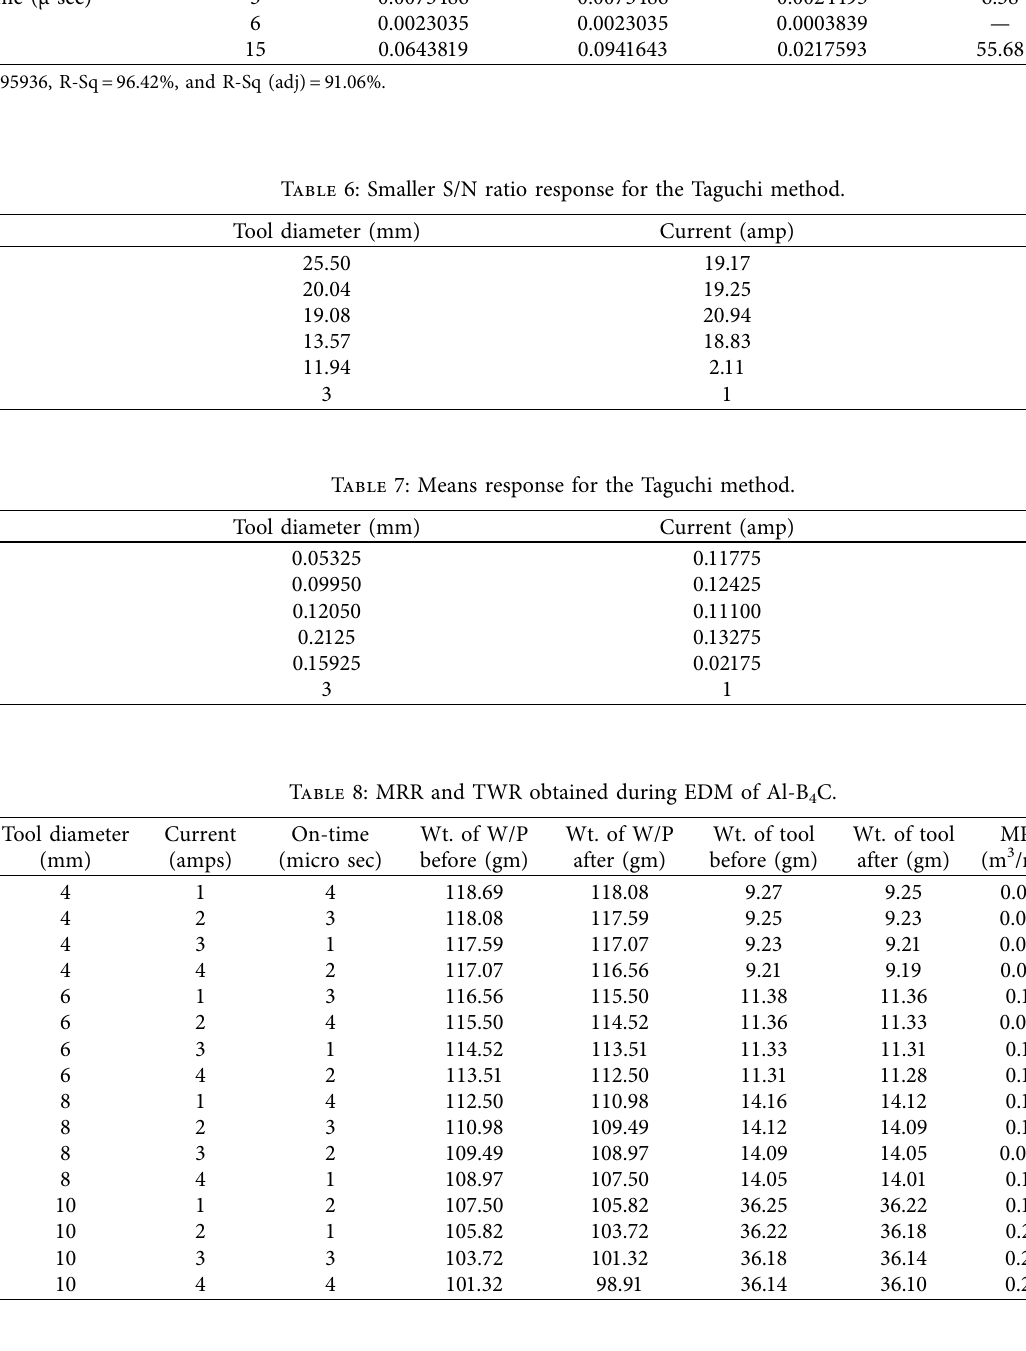
Table 6: Smaller S/N ratio response for the Taguchi method.